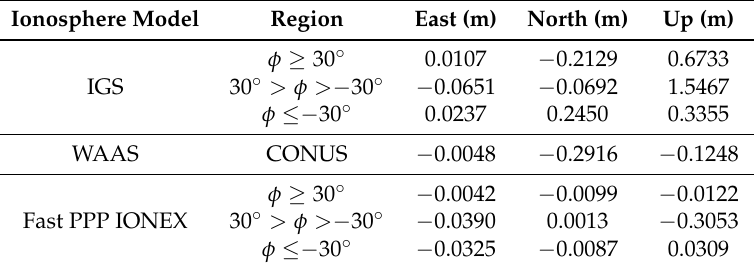
Table 1. Long-term average position error due to ionospheric model errors ( φ denotes station latitude). IGS: International Global Navigation Satellite System (GNSS) Service; PPP: precise point positioning;